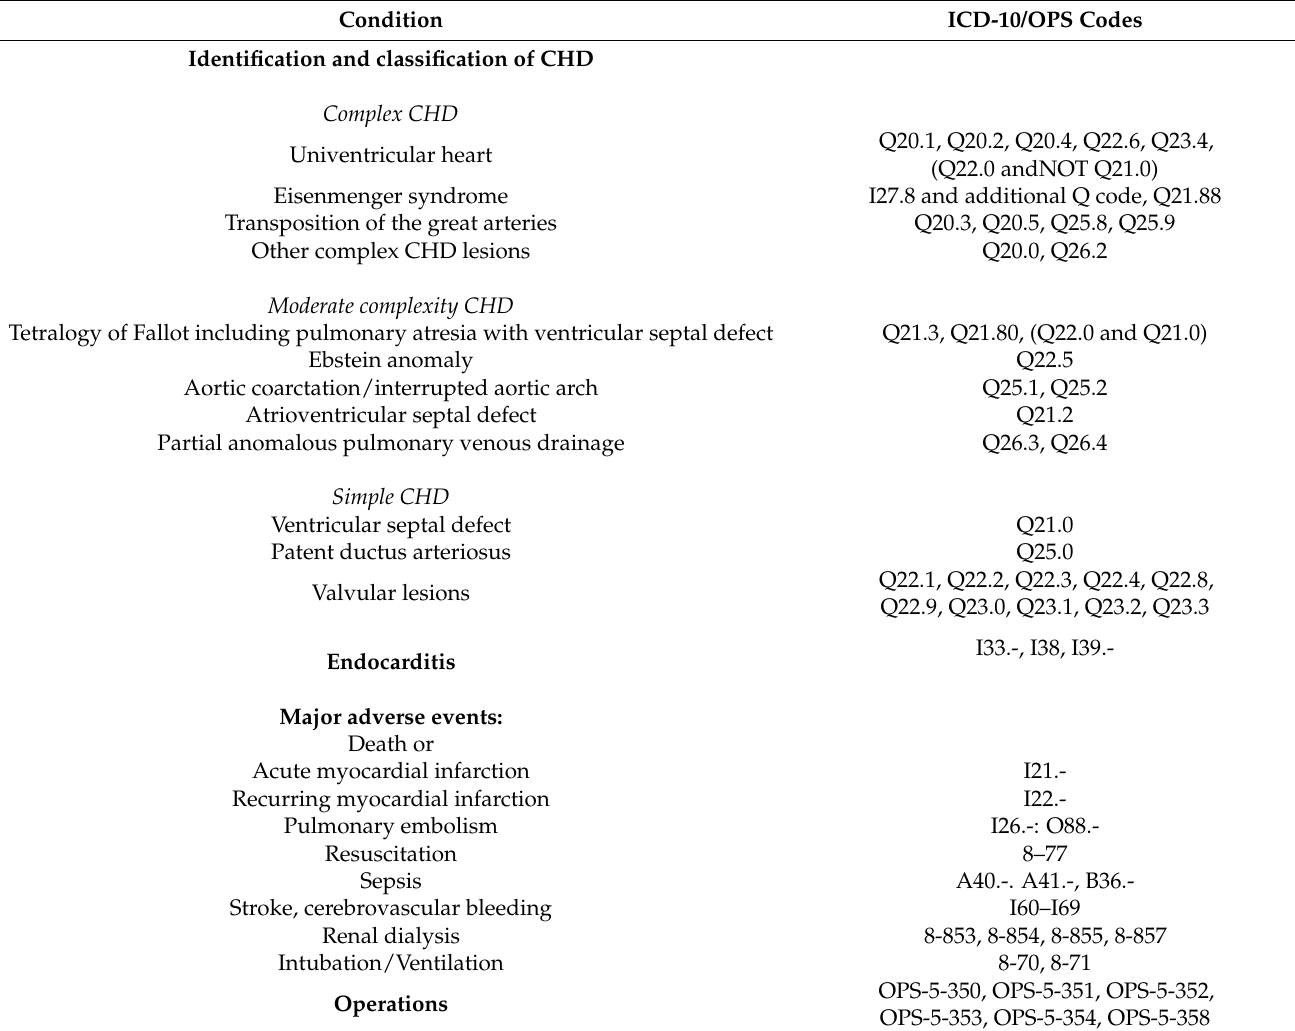
Table 1. List of relevant ICD-10 or OPS codes utilized. CHD = congenital heart disease; ICD = International Classification of Diseases; OPS = Operation and Procedure key